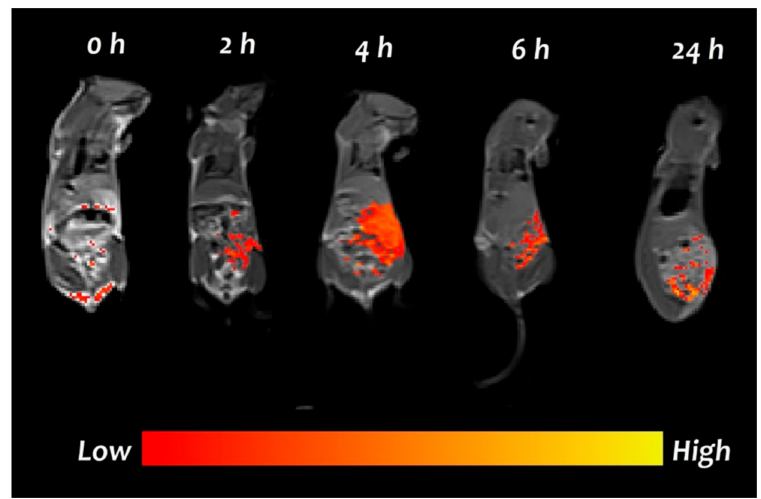
Figure 9. MR images of BALB/C mice after injection (0 h, 2 h, 4 h, 6 h, and 24 h) with highest accumulation of nanoclusters in the tumor area after 4 h.